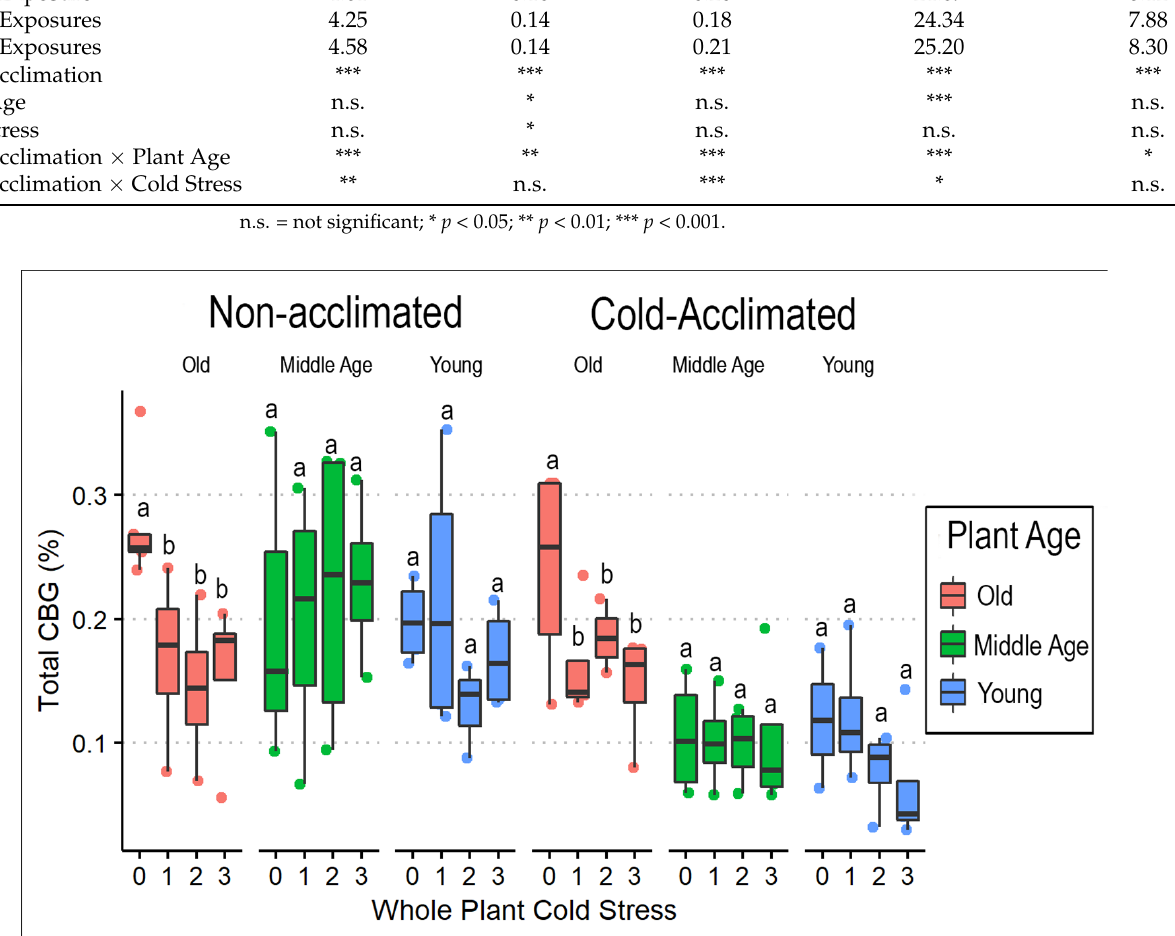
Figure 8. Total THC (%) box plots comparing whole-plant cold stress to acclimation treatment and plant age in ‘AutoCBD’. Data represent the percentage of THC added to the product of the percent- age of THCA multiplied by the cannabinoid’s molecular weight ratio (0.878). Plants receiving cold acclimation treatment were subject to 10 days at 10 °C. Whole-plant cold stress consisted of a control treatment receiving no cold exposure, 0 (control); a single 3 h − 0.5 °C exposure, 1 ; two consecutive